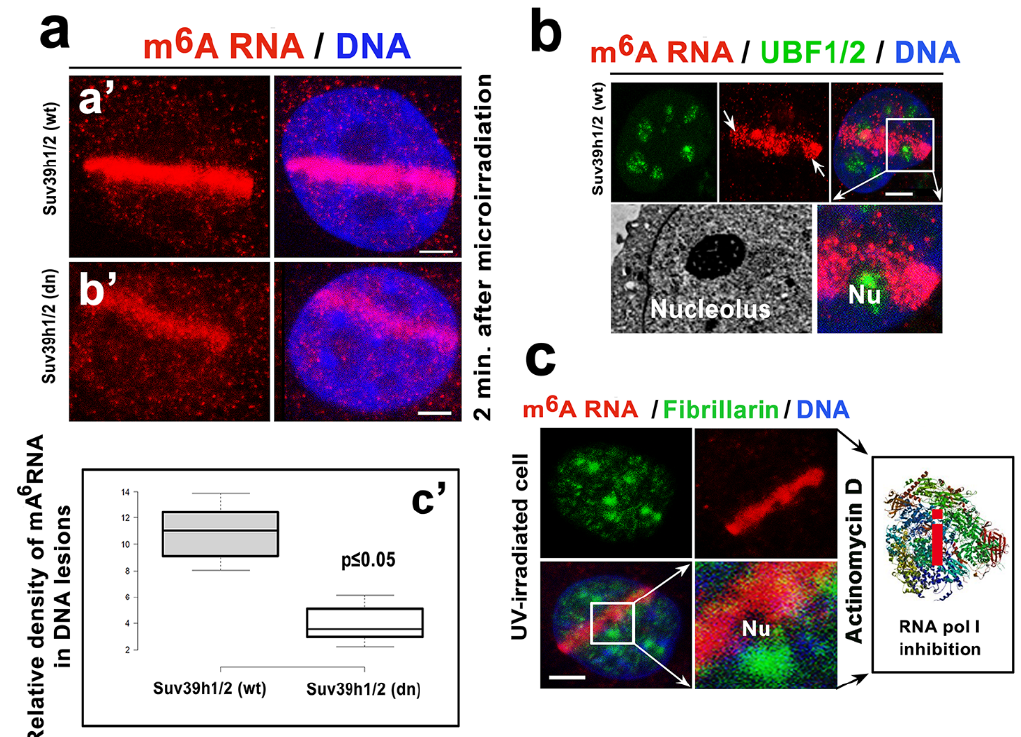
Figure 3. The level of m 6 A RNA was lower in microirradiated Suv39h1 / h2-depleted cells and changes in m 6 A RNA were not observed in the nucleoli of cells exposed to UVA light. ( a ) Suv39h1 / h2 depletion a ff ected the level of m 6 A RNAs at the locally microirradiated chromatin (compared to the levels in ( a’ ) Suv39h1 / h2 wt and ( b’ ) Suv39h1 / h2 dn cells). A relative density of m 6 A RNA in microirradiated ROI is shown in panel ( a , c’ ). Scale bars in panels a-c represent 5 µ m. ( b ) The m 6 A RNAs were absent in the UBF1 / 2-positive region of the nucleoli, and ( c ) m 6 A RNAs were absent in fibrillarin-positive regions of the nucleoli, in the cells treated by RNA pol I inhibitor, actinomycin D. For a pictorial illustration of RNA pol I inhibition (red i), the structure of the RNA polymerase I at a 2.8 A resolution was taken from the PDB database [50].